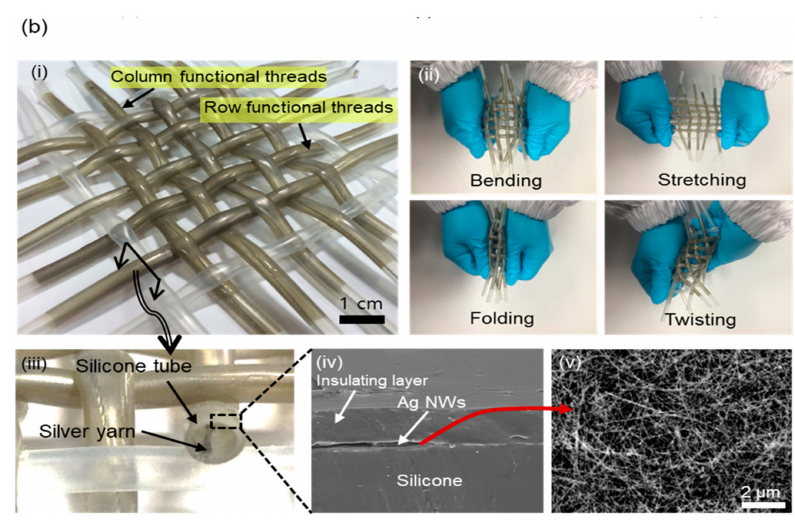
Figure 5. ( a ) Fabrication steps: (i) 3-aminipropyltriethoxysilane (APTES) coating on outer surface of tube. (ii) Ag NWs coating on surface. (iii) FOTS coating on inner surface. (iv) Coating of polydimethylsiloxane (PDMS)-EcoFlex layer. (v) Inset of silver yarn. (vi) Weaving threads into textile structure. ( b ) Photograph of fabricated device: (i) Fabricated device. (ii) Bending, stretching,